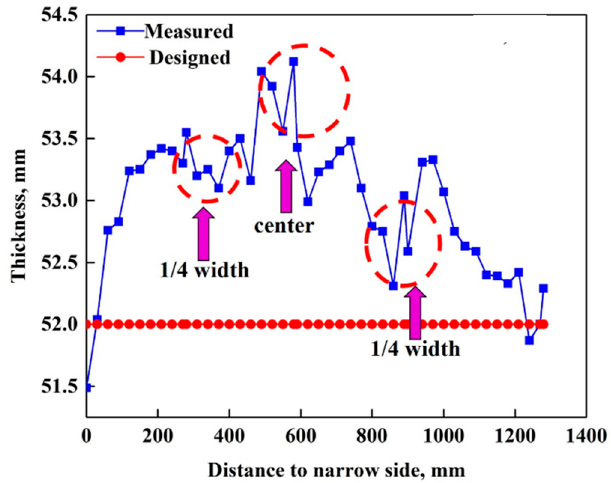
Figure 10. Thickness changes along the width direction.